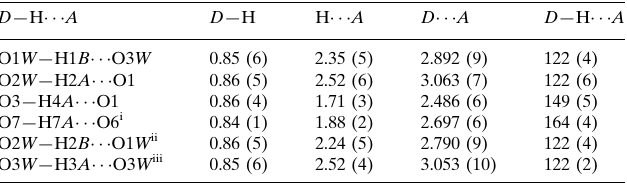
Hydrogen-bond geometry (A˚ , (cid:3)